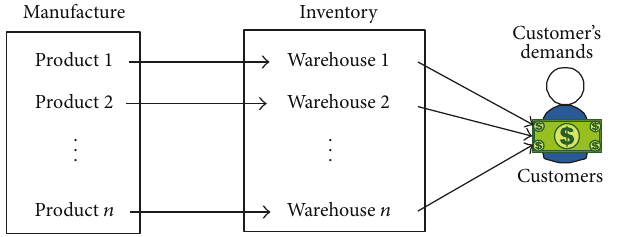
Figure 3: The inventory system of H Chain Co., Ltd.